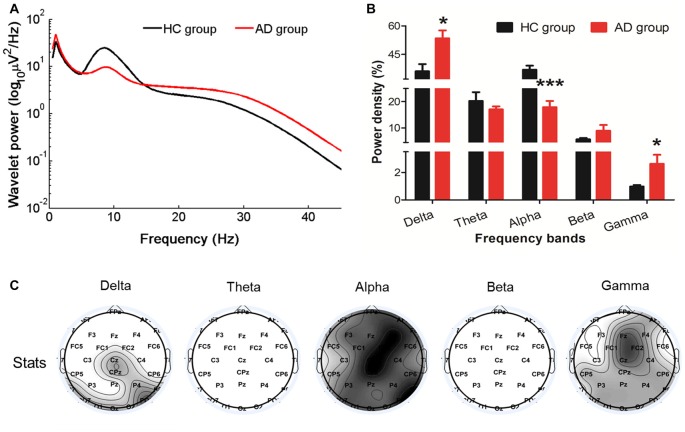
Changes in the EEG power spectra in the Alzheimer’s disease (AD) group compared with the healthy control (HC) group. (A) The average absolute EEG power in HCs (black line) and AD patients (red line). The Y-axis represented the power value and the X-axis represented frequency bands. (B) The relative power (normalized to the overall power) in five frequency bands. A marked increase of the relative power in delta and gamma frequencies and a decrease in alpha frequency was observed in the AD group (red columns) compared with the power in the HC group (black columns). *PFDR < 0.05, ***PFDR < 0.001 compared with the HC group. All data were expressed as the means ± SEM (n = 8–12). (C) Topographic distribution of statistical significances in EEG power in the AD group compared with the HC group. Values were color coded. Black: P < 0.001; dark gray: P < 0.01; light gray: P < 0.05; white: not significant, uncorrected for the number of electrodes tested.